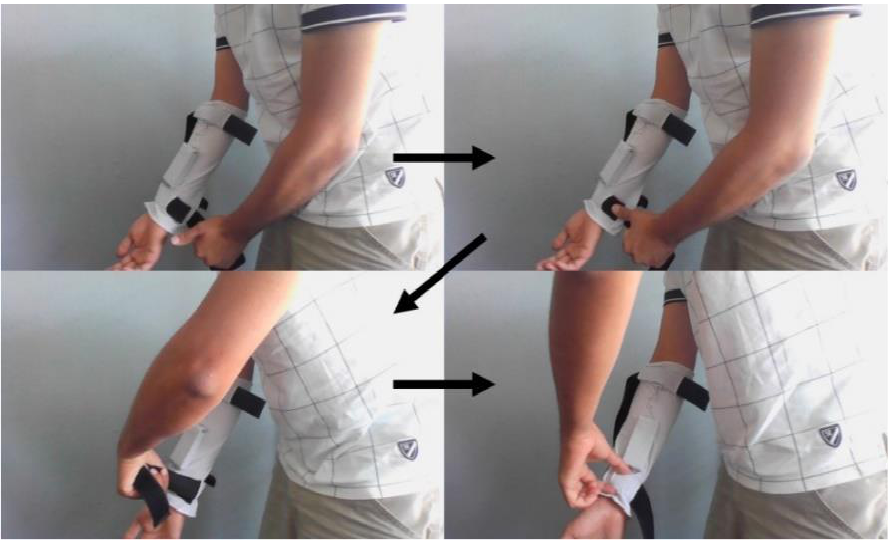
Figure 5. The sequence of one-handed closing of the straps. First, the end of the strap is gripped in the hand. Next, the start of the strap is held down with the thumb. While holding this down with the thumb, the strap end can be looped over and closed. Finally, the vibration pod location within the sleeve can be